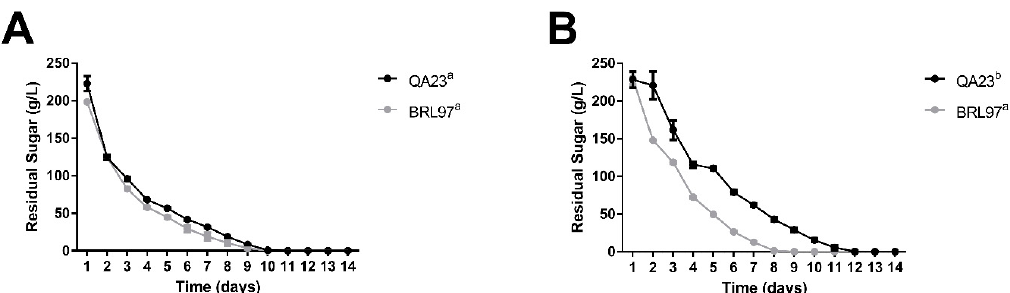
Figure 1. Daily residual sugar levels (g/L ± SEM) of controlled fermentations conducted by different yeast strains ( n = 4 per treatment). Fermentations were conducted in the presence of either ( A ) 0 mg/L SO 2 or ( B ) 50 mg/L SO 2 . Treatments with different superscript letters indicate significantly different fermentation progressions (2-factor repeated measures ANOVA, α = 0.05).